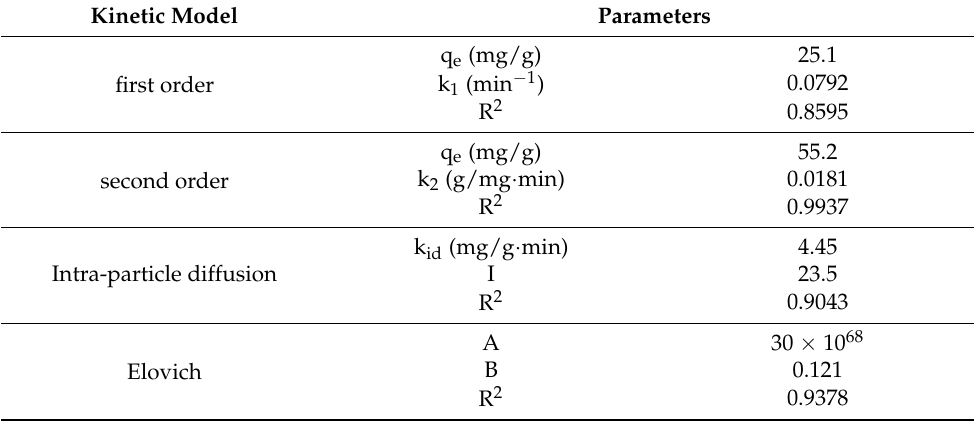
Table 1. Kinetic data of the adsorption of Pb(II) ions onto